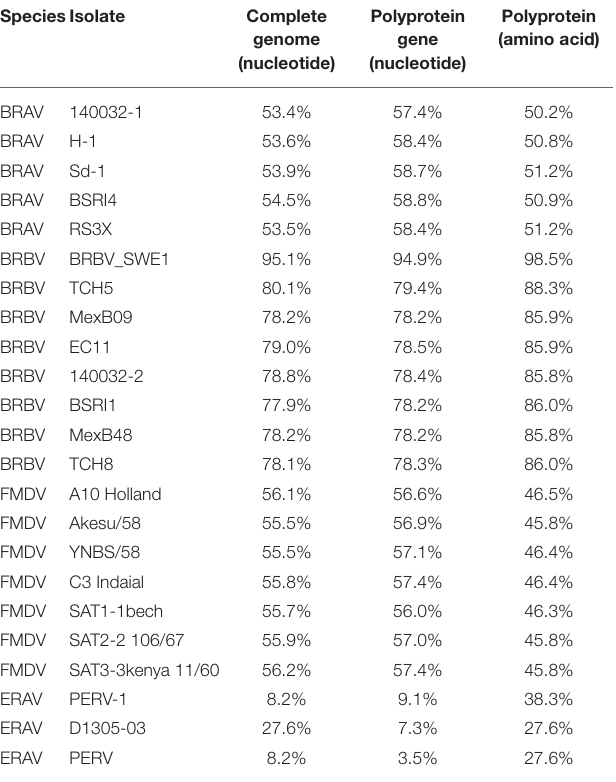
TABLE 3 | Similarity of CHN1 with other member from the genus Aphthovirus . SpeciesIsolate